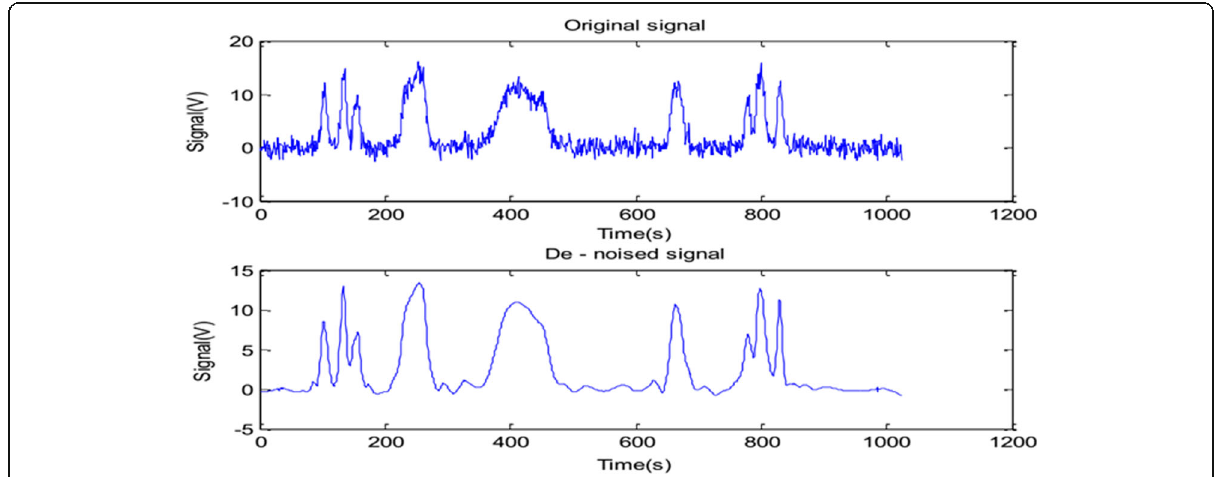
Fig. 2 Comparison between the original audio signal and the denoised audio